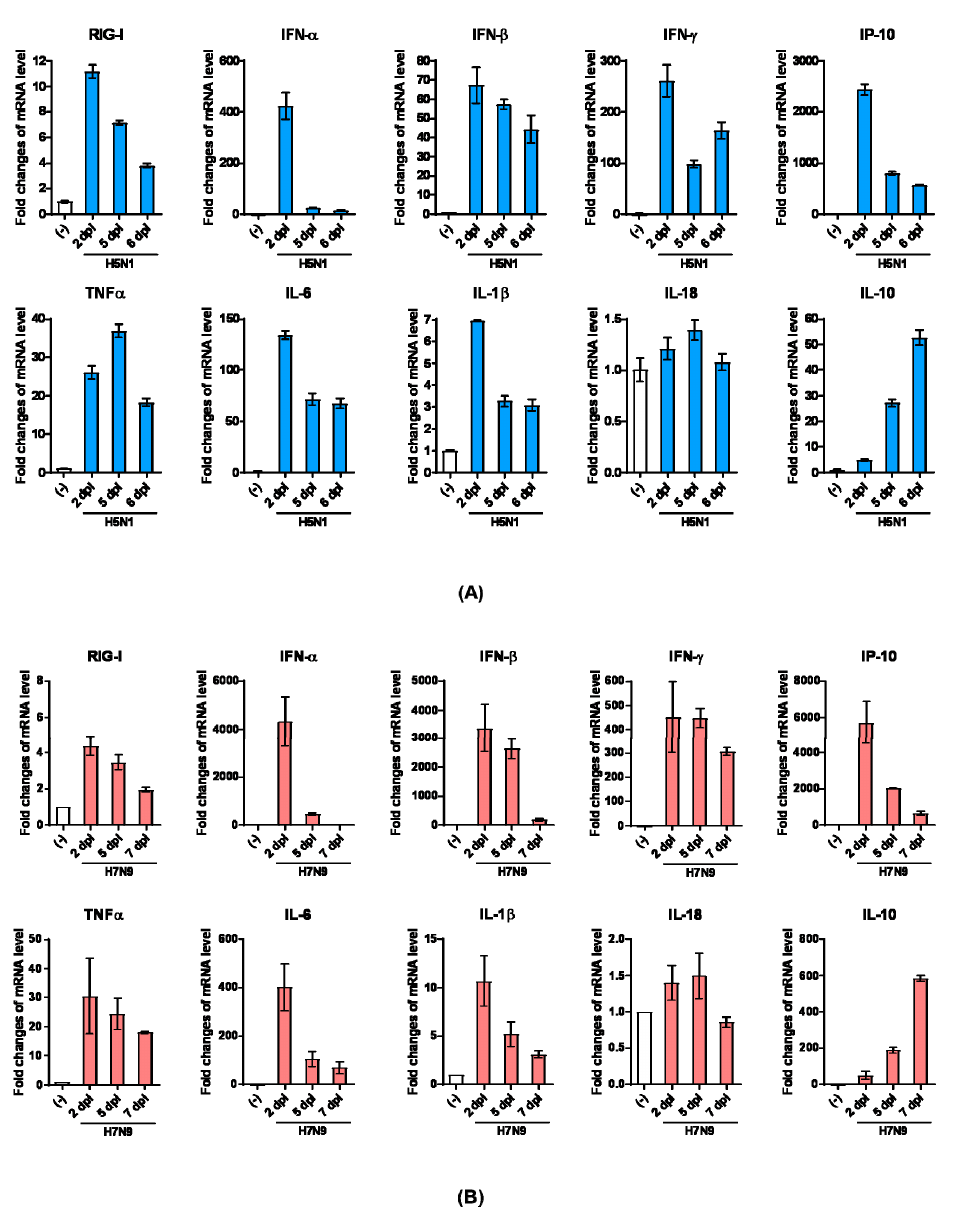
Figure 4. Innate immune receptor RIG-I, as well as cytokine and chemokine gene transcription levels in the lungs of mice infected with the AB14 (H5N1) and BC15 (H7N9) strain isolates. Cytokine and chemokine mRNA levels of RIG-I, IFN- α , IFN- β , IFN- γ , IP-10, TNF- α , IL-6, IL-1 β , IL-18, and IL-10 from virus-infected lungs with ( A ) AB14 (H5N1) and ( B ) BC15 (H7N9) ( n = 3 mice per virus group) were measured by qRT-PCR. Samples were harvested on the indicated d.p.i.; each sample was tested in triplicate.